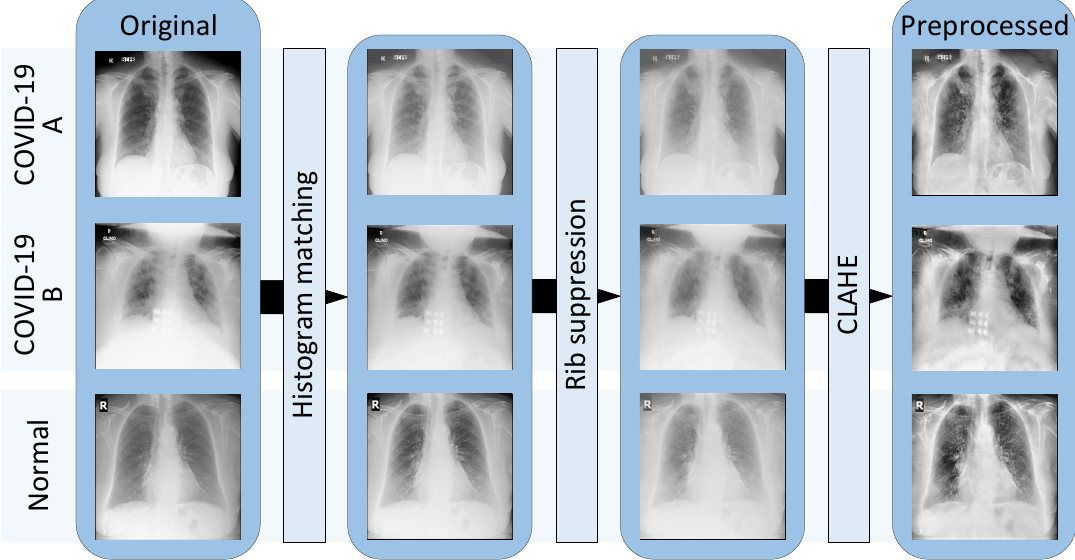
Figure 1. Preprocessing flowchart describing the different steps to obtain the final images for the dataset. COVID-19 A and B correspond to images from BIMCV-COVID19 and the COVID-19 image data collection from Cohen et al.,